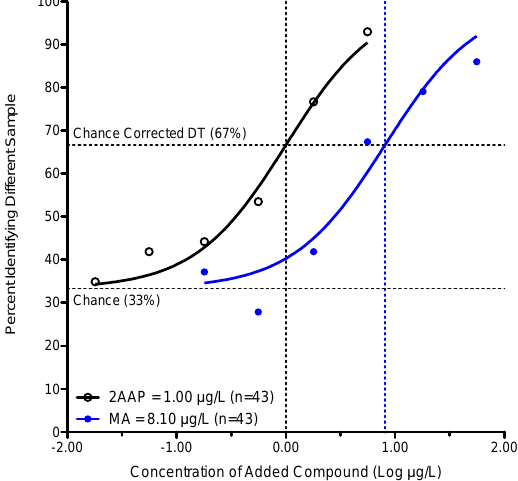
Figure 2. Detection Thresholds (DTs) for Methyl Anthranilate versus 2-aminoacetophenone in water. The group response rates were plotted against the log concentration of the added compound (2AAP: open black circles, MA: shaded blue circles) and fitted using the Hill Equation.